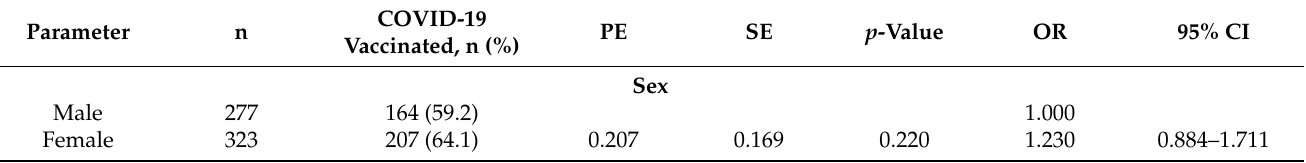
Table 4. Univariate logistic regression showing the relationship between students vaccinated against COVID-19 and various